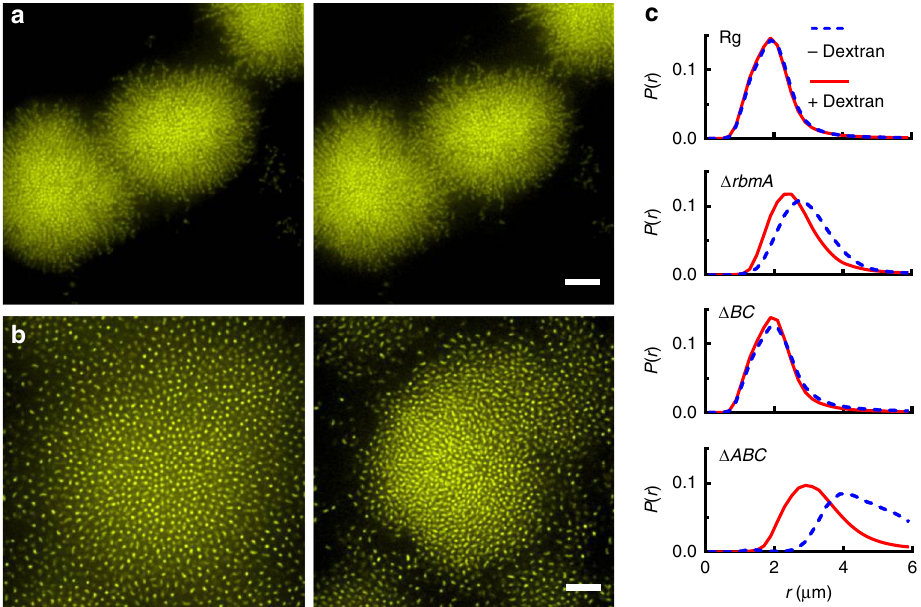
Fig. 5 Osmotic pressure controls the expansion of submerged V. cholerae bio fi lms. a , b Cross-sectional confocal images of submerged a Rg and b Δ rbmA bio fi lms before ( left ) and immediately after ( right ) hyperosmotic shock generated by addition of 15% dextran to the media. Cells constitutively express mKO from the chromosome. Images are at 6 and 10 μ m above the surface in a and b , respectively. Scale bars : 10 μ m. c Probability distribution of the cell-to-cell distance r in the designated submerged bio fi lms, before ( dashed blue curve ) and immediately after ( solid red curve ) hyperosmotic